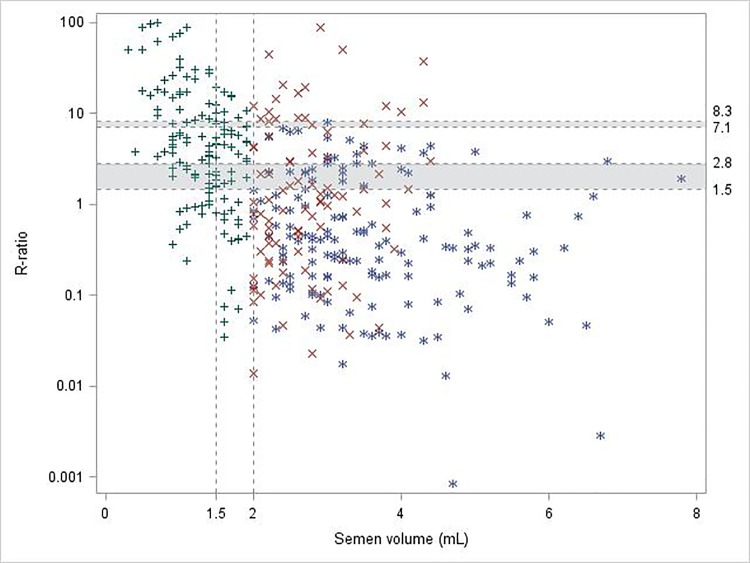
Distribution of patients according to R-values and semen volume.Reference lines were drawn on x-axis to represent WHO lower reference limits for semen volume (1.5 mL [20] and 2 mL [16]) and on y-axis to represent low and high R-value thresholds obtained from CART procedure (1.5% and 2.8%, 7.1% and 8.3% respectively). + (green), 146 patients with observed low semen volume (<2 mL) × (red), 99 patients with normalized semen volume (≥ 2 mL) * (blue), 162 patients with normal semen volume (≥ 2 mL).